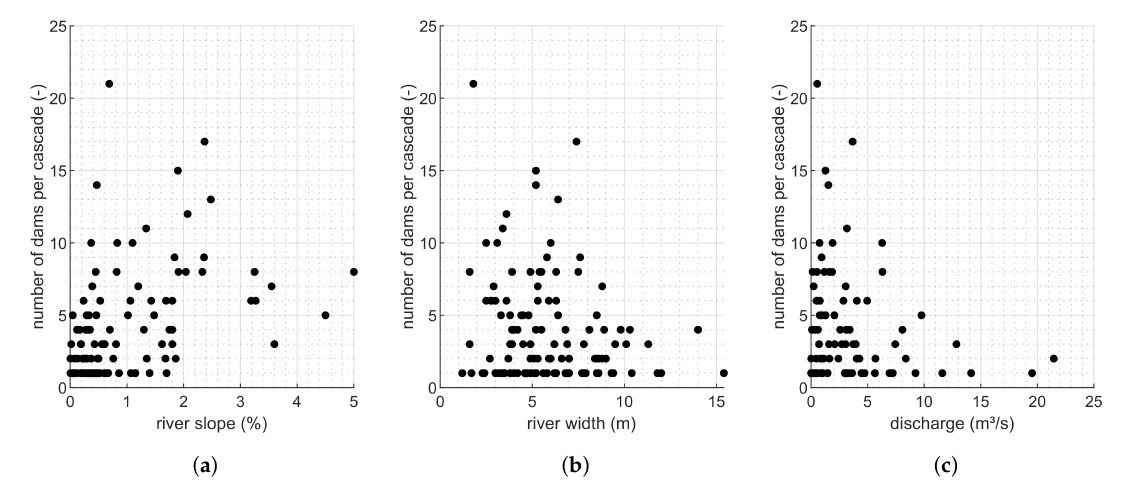
Figure 4. Scatter plots of the number of dams per cascade and multiple parameters describing cascade location properties. ( a ) river slope, ( b ) river width, and ( c ) peak discharge for a return period of 2